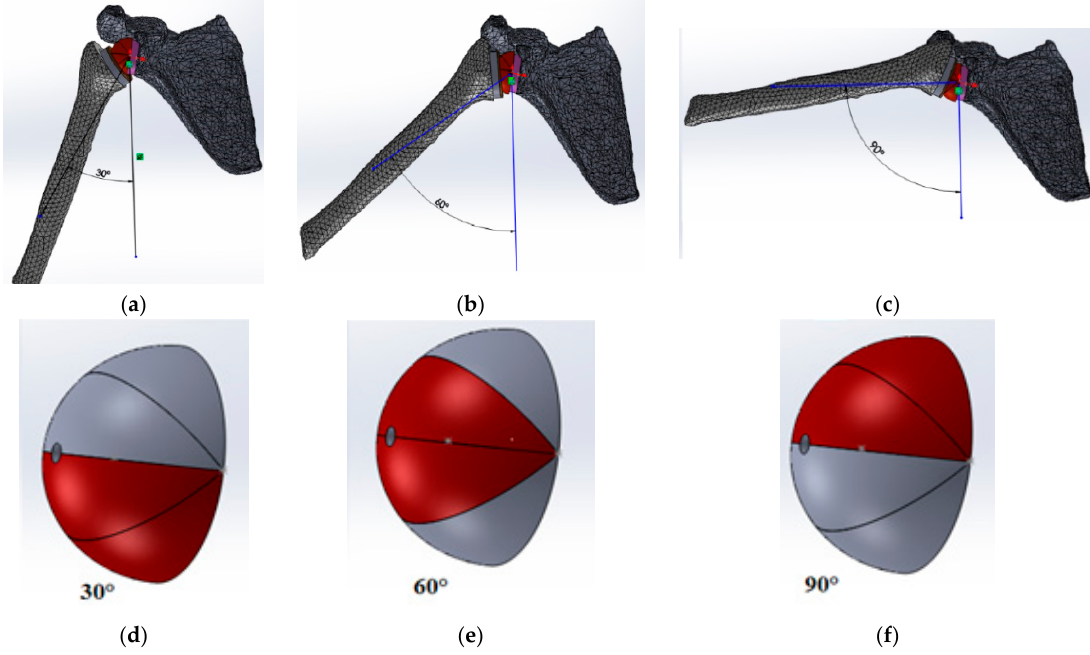
Figure 5. Contact surfaces and zone of applied forces on the glenosphere depending on arm inclination ( a ) 30° position; ( b ) 60° position; ( c ) 90° position; ( d ) applied force for 30°; ( e ) applied force for 60°; ( f ) applied force for 90°.